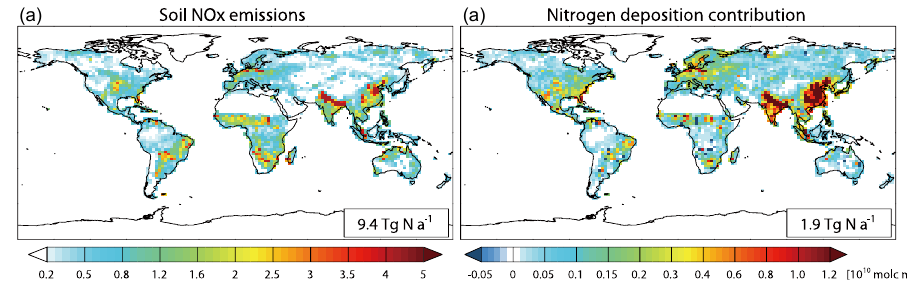
Figure 5. Present-day soil NO x emissions (left) and contributions from anthropogenic nitrogen deposition (right). Annual totals are shown